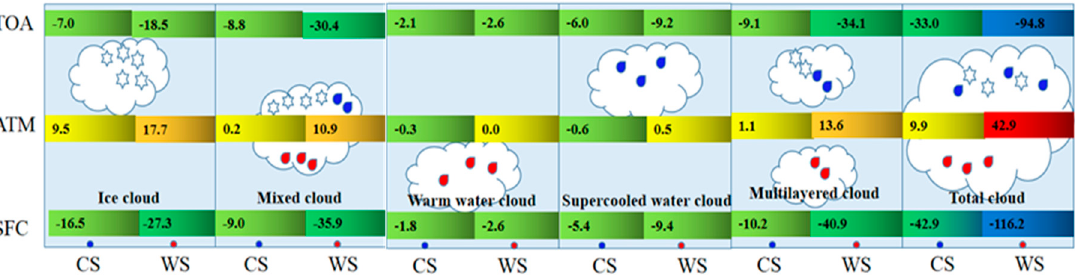
Figure 5. Four-year CRE (Wm − 2 ) of ice clouds, mixed-phase cloud, supercooled water clouds, warm water clouds, multilayered clouds, and total clouds at the TOA, ATM, and SFC over the TP (The left-to-right values of each cube indicate the CRE of different cloud phases during the cold season and warm season, respectively. The small spheres of different colors above each line represent different seasons, with blue and red for the cold and warm seasons, respectively. Here, the first four different cloud phases refer to the case of single-layer clouds.).